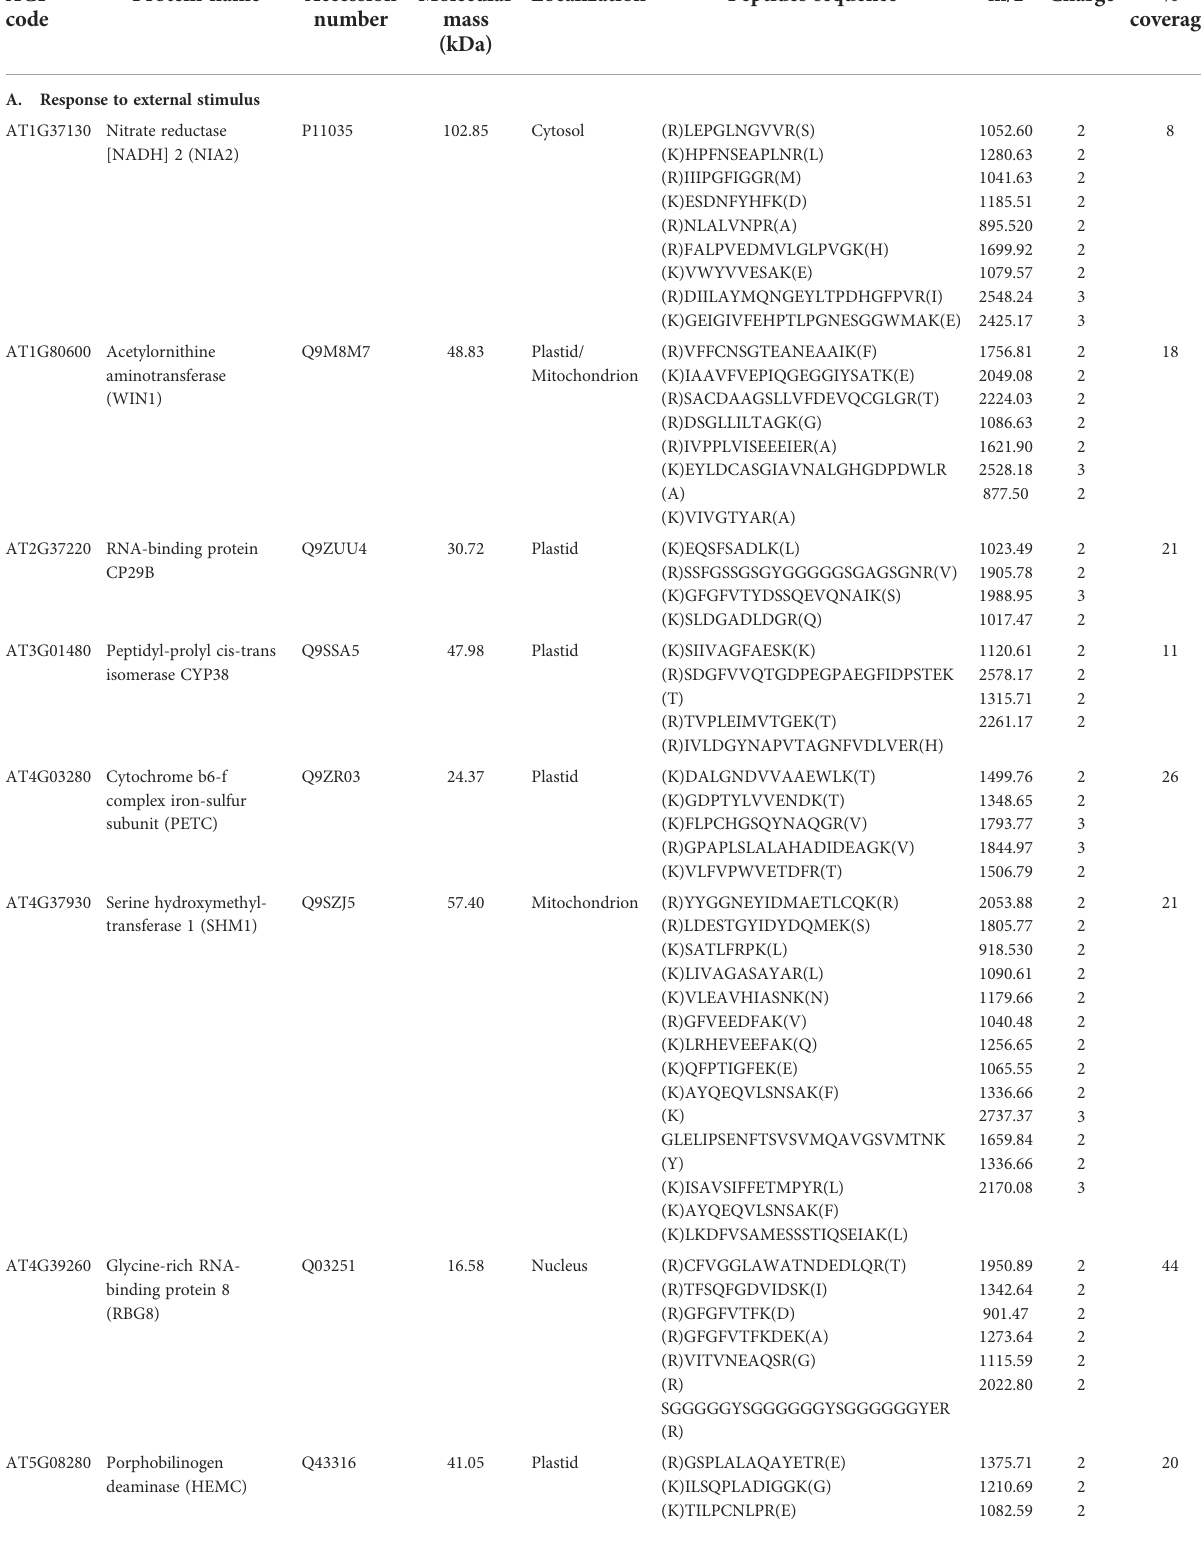
TABLE 2 Examples of carbonylated proteins identi fi ed only in H 2 O 2 -treated plant samples a